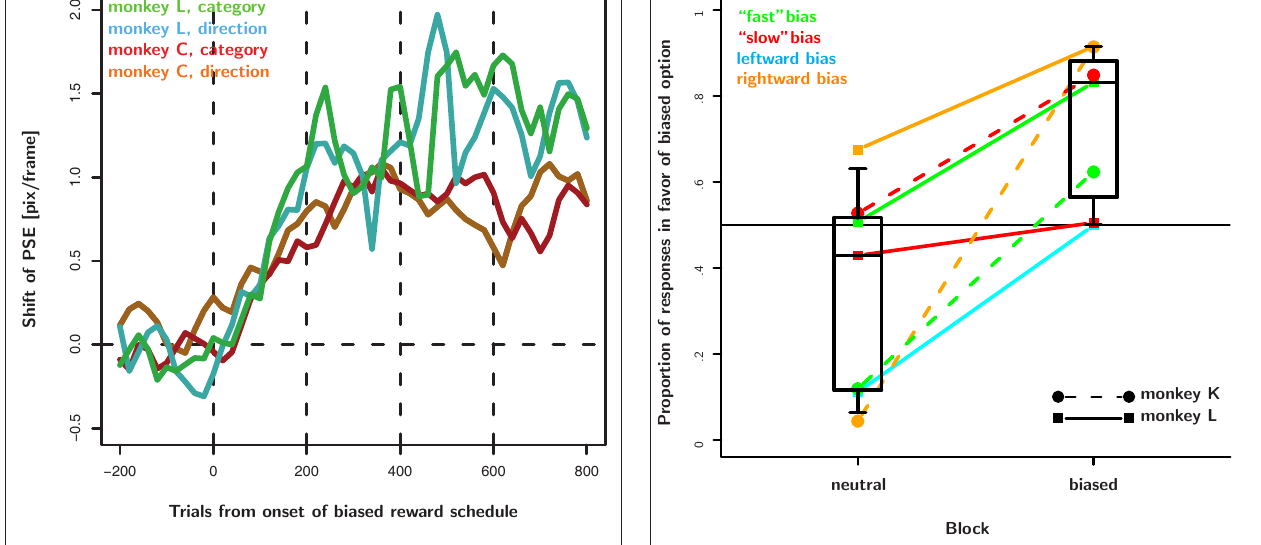
Figure 7 | results from the value-based decision task. The proportion of choices in favor of the biased response is plotted separately for the neutral and the biased blocks. Data from a particular bias type are connected by a dotted line. The plotting symbol and line type indicate the subject. In every single session, subjects shifted their preferences in favor of the response that was more likely to be correct. On most days this effect was quite strong and caused the monkeys to choose the biased response 80% of the time or more. On some days, however, the effect was rather small. This seemed to be the case when an animal already had a very strong bias, e.g., toward a particular direction and the likelihood manipulation favored a particular color. Further, while both monkeys responded to the reward likelihood manipulations, monkey K responded stronger and with a shorter delay than monkey L. As monkey K already had a very strong natural rightward preference, we did not run the rightward bias condition. The response bias in the neutral block is caused mainly by carry-over effects from the bias introduced on the previous